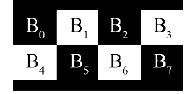
Figure 4. Parity check for coding box